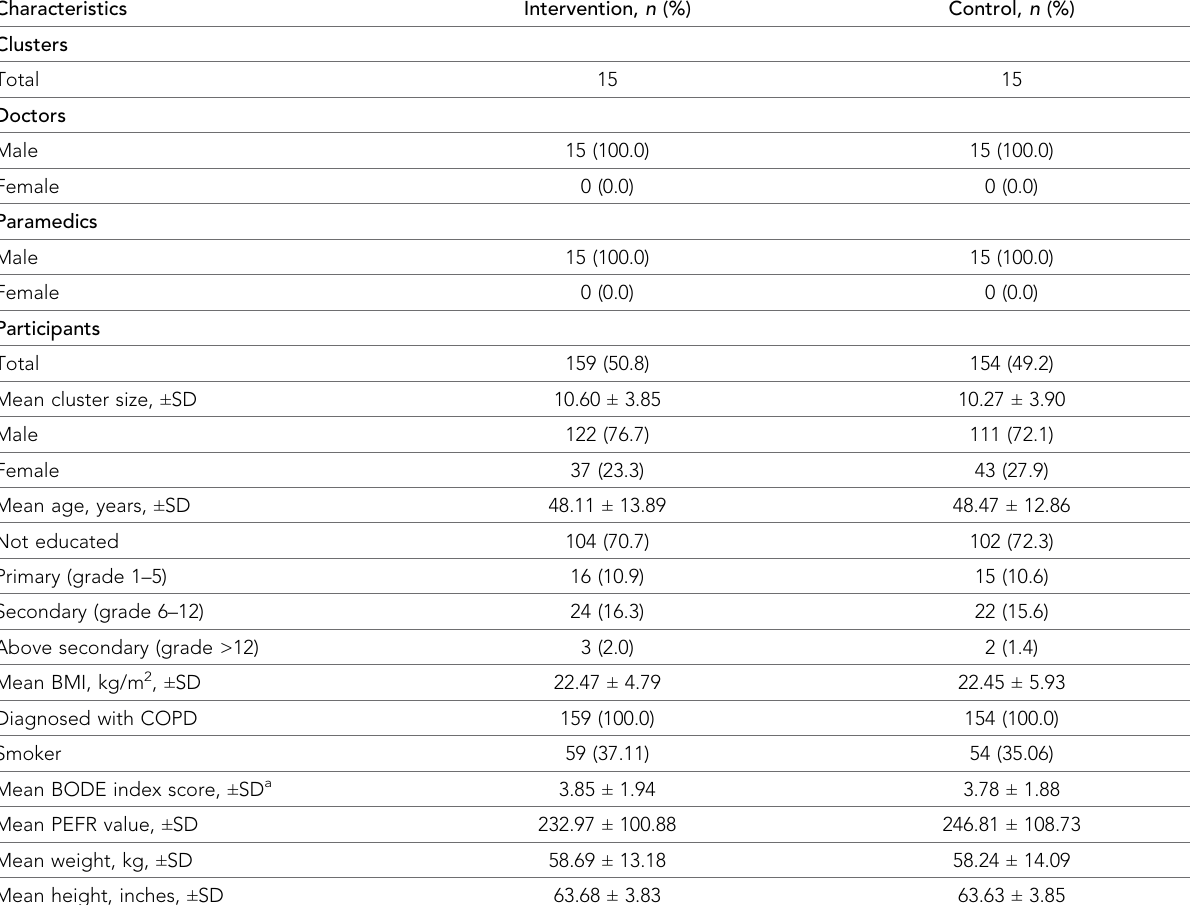
Table 1. Baseline